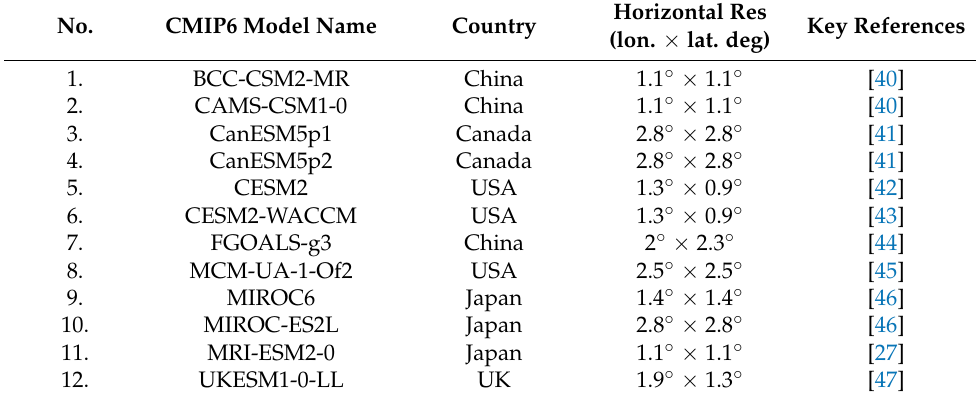
Table 1. List of employed CMIP6 climate models for evaluation and projection of the UBNB climate. No. CMIP6 Model Name Country